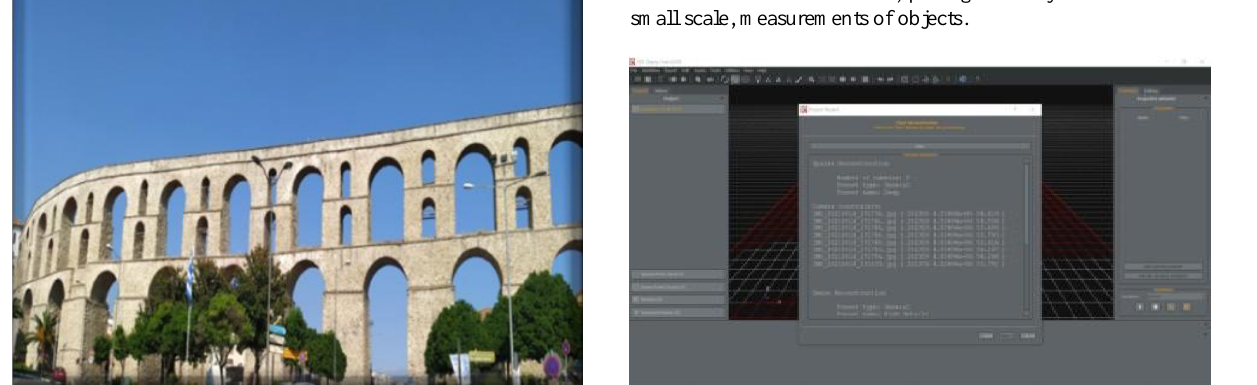
Figure 4 . Photography of the Front – Side